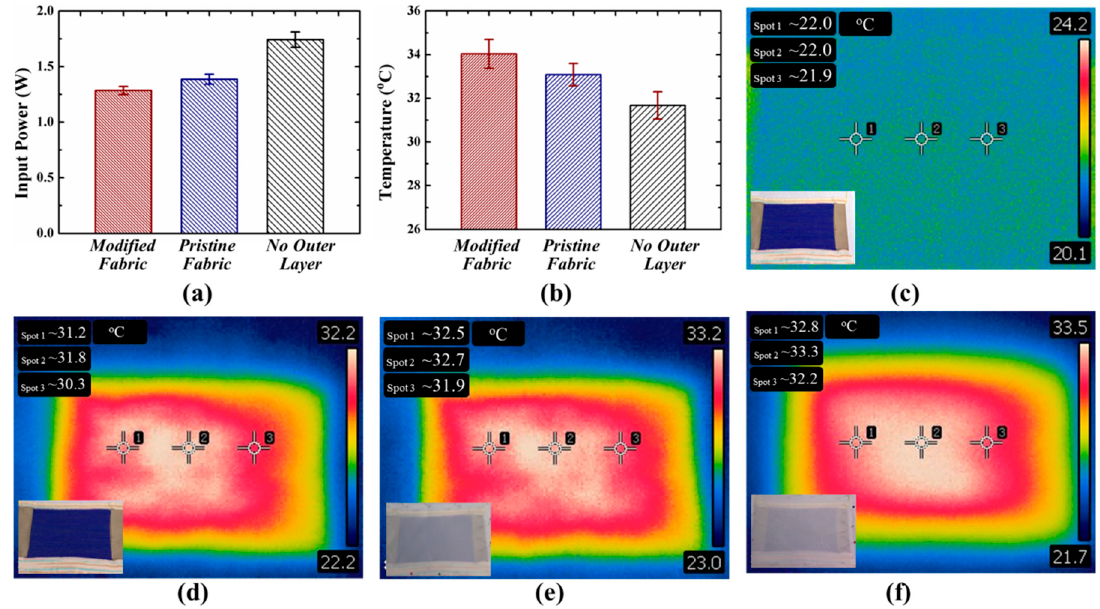
Figure 3. ( a ) The input power for different ETs to achieve the thermal equilibrium temperature of 34 °C; ( b ) The thermal equilibrium temperature of different ETs under the same input power of 1.29 W. Thermal images of ETs without outer layer ( c ) before and ( d ) after applying an input power of 1.29 W. Thermal images of ( e ) pristine fabric-based ET and ( f ) modified fabric-based ET after applying an input power of 1.29 W.